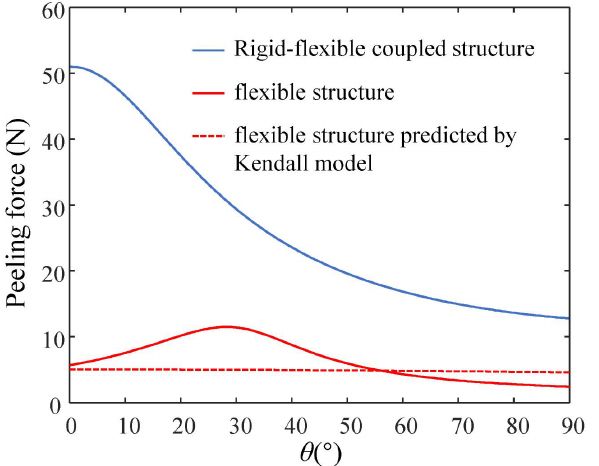
Figure 10. Variation of the peeling force with the peel angle for the rigid-flexible coupling adhesive unit and the flexible adhesive